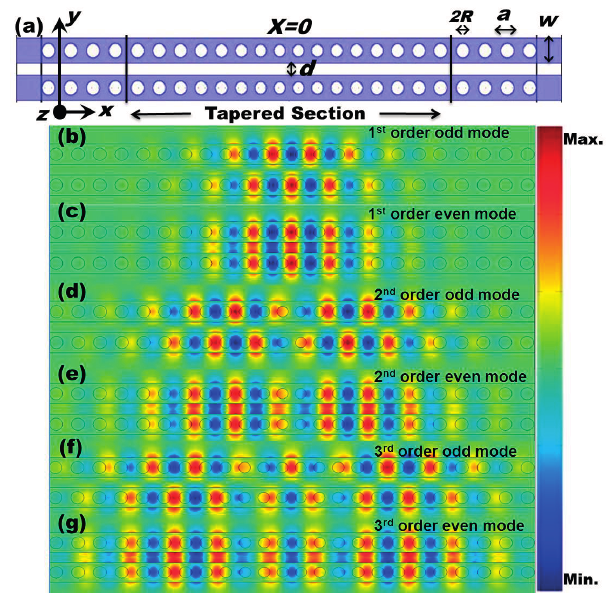
Figure 2. ( a ) Schematic of the investigated biosensor based on the laterally coupled